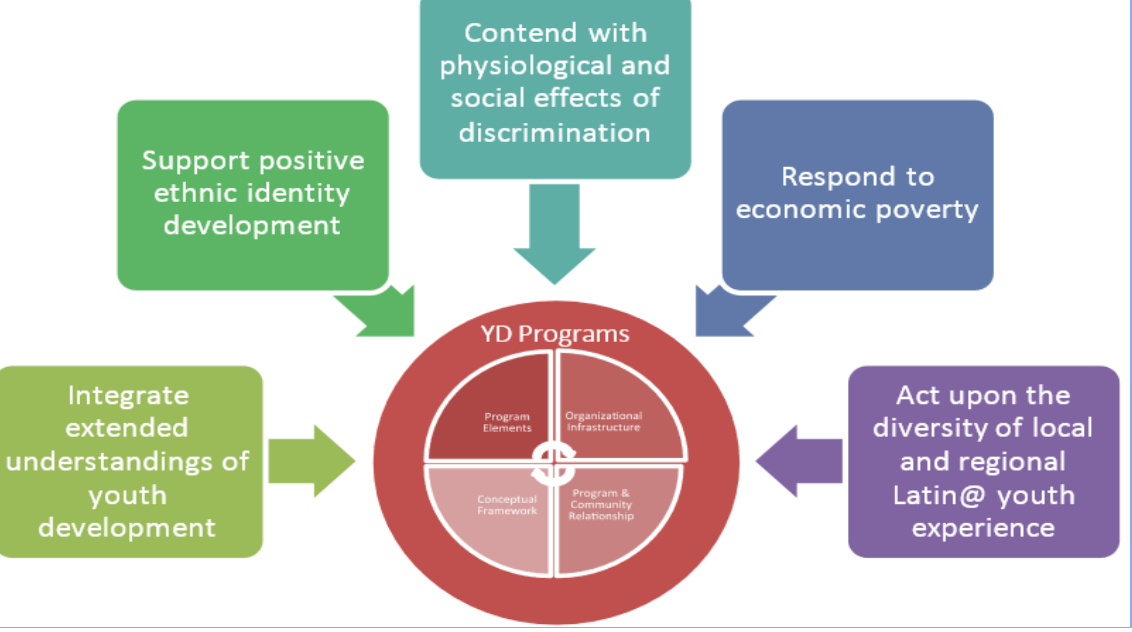
Figure 1. Practices Associated With Latin@ Youth Engagement in Youth Development Programs (Erbstein & Fabionar,